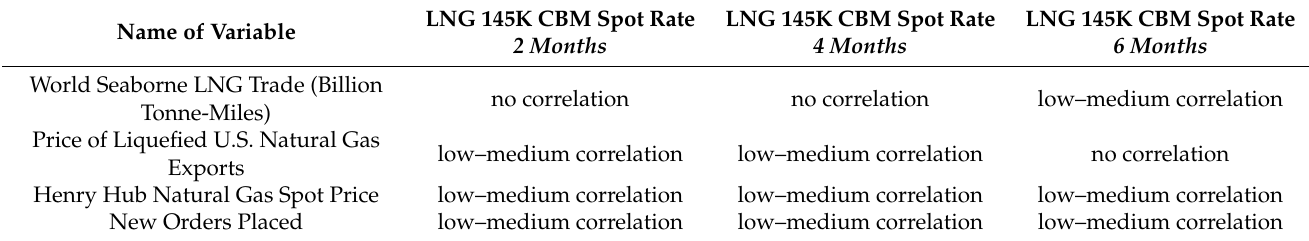
Table 6. Variables with no or low correlation with the prediction